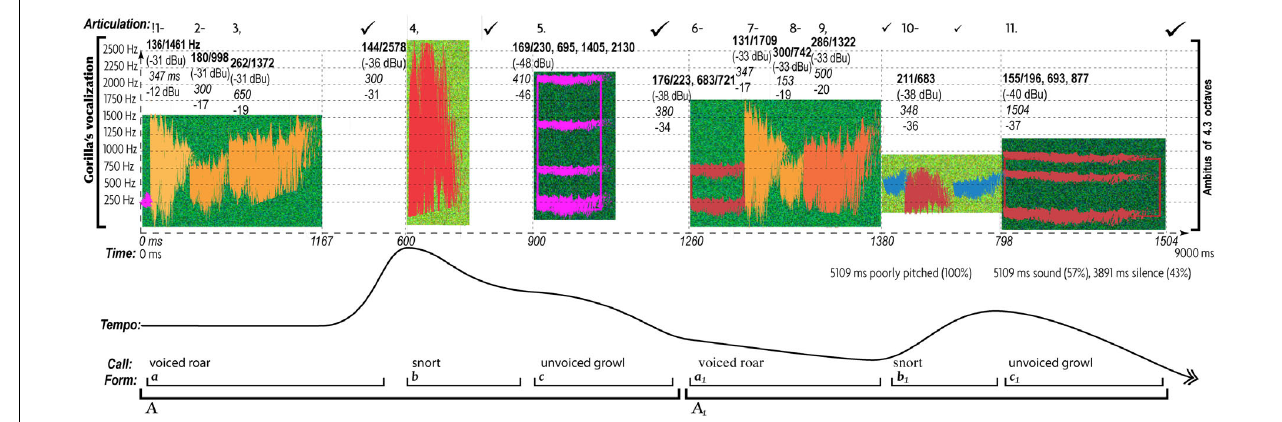
FIGURE 4 | Characteristic patterns of AEs in expression of anger in gorilla’s calls (http://chirb.it/72g63y). Approaching primate’s vocalizations with the same multifactorial analytical method as human music reveals important differences in TO. The most noticeable is complete absence of harmonious sounds with clear FF and legato articulation. The share of silence doubles: 43% (versus 17% of Figure 3 ). The form is simpler—no motifs conjoin into a phrase. Calls (voiced roar, non-voiced growl, and snort) remain detached except for a few instances of joining snort and growl together. The same disconnectedness characterizes all temporal AEs. The onset of each of the calls exposes a sort of an irregular pulse. However, the rate of this pulse is more than twice slower than the angry human music ( Figure 3 ) and its deviation from a regular pulse is nearly twice greater—exceeding even the slow and flexible “loving music” ( Figure 2 ). In essence, it would be accurate to characterize these vocalizations as rhythmically irregular, ametric, and undifferentiated in pitch. None of the calls generate a clear pitch contour due to their very broad band (up to 4.2 octaves). The calls’ bandwidth was calculated by taking measurements of the frequency of that portion of the spectrum which stood out from the rest of the signal. Unlike music, gorilla’s call-motifs do not break the ambitus into registers but timbrally recolor the entire ambitus for each of the calls, thereby increasing their